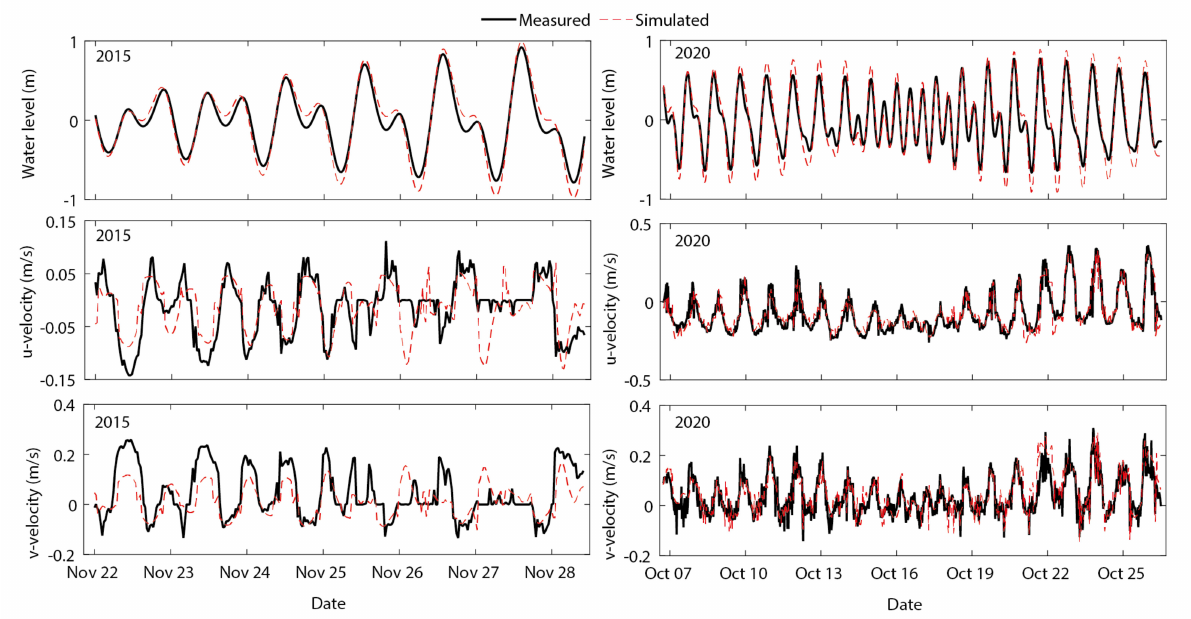
Figure 3. Time series comparison between measured and simulated water level and u and v velocities of the water current during 2015 ( left panels) and 2020 ( right panels). Please refer to Figure 2 for station